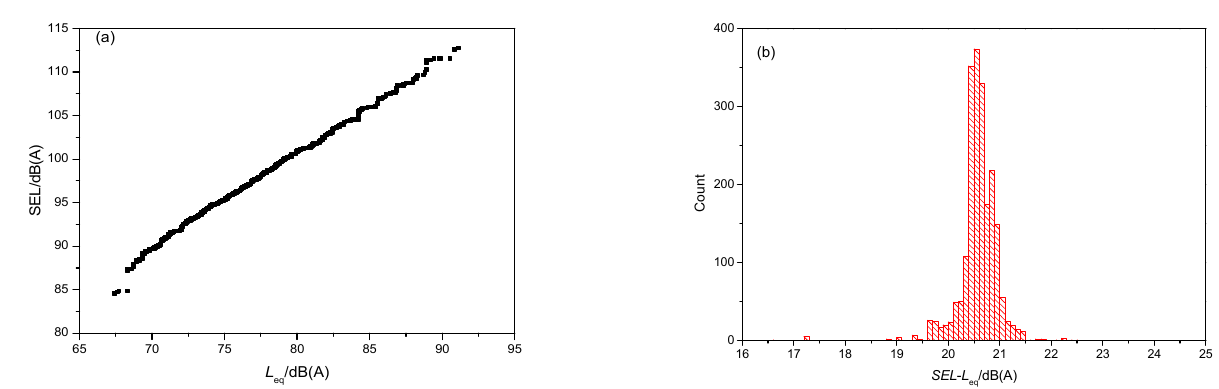
Figure 14. Relationship between SEL and equivalent SPL: ( a ) SEL vs. L eq and ( b ) statistical result of the difference between SEL and L eq for all test samples.